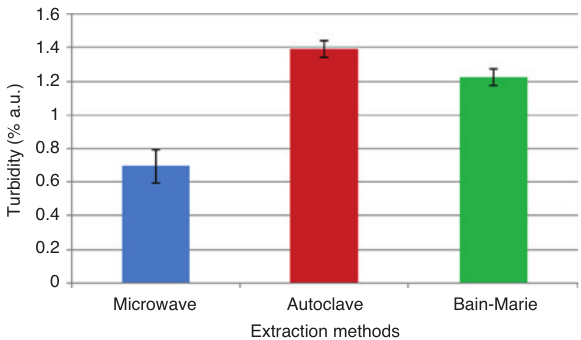
Figure 6: Turbidity of the saponin extracts obtained using three different extraction methods. Data are mean values of three replications.